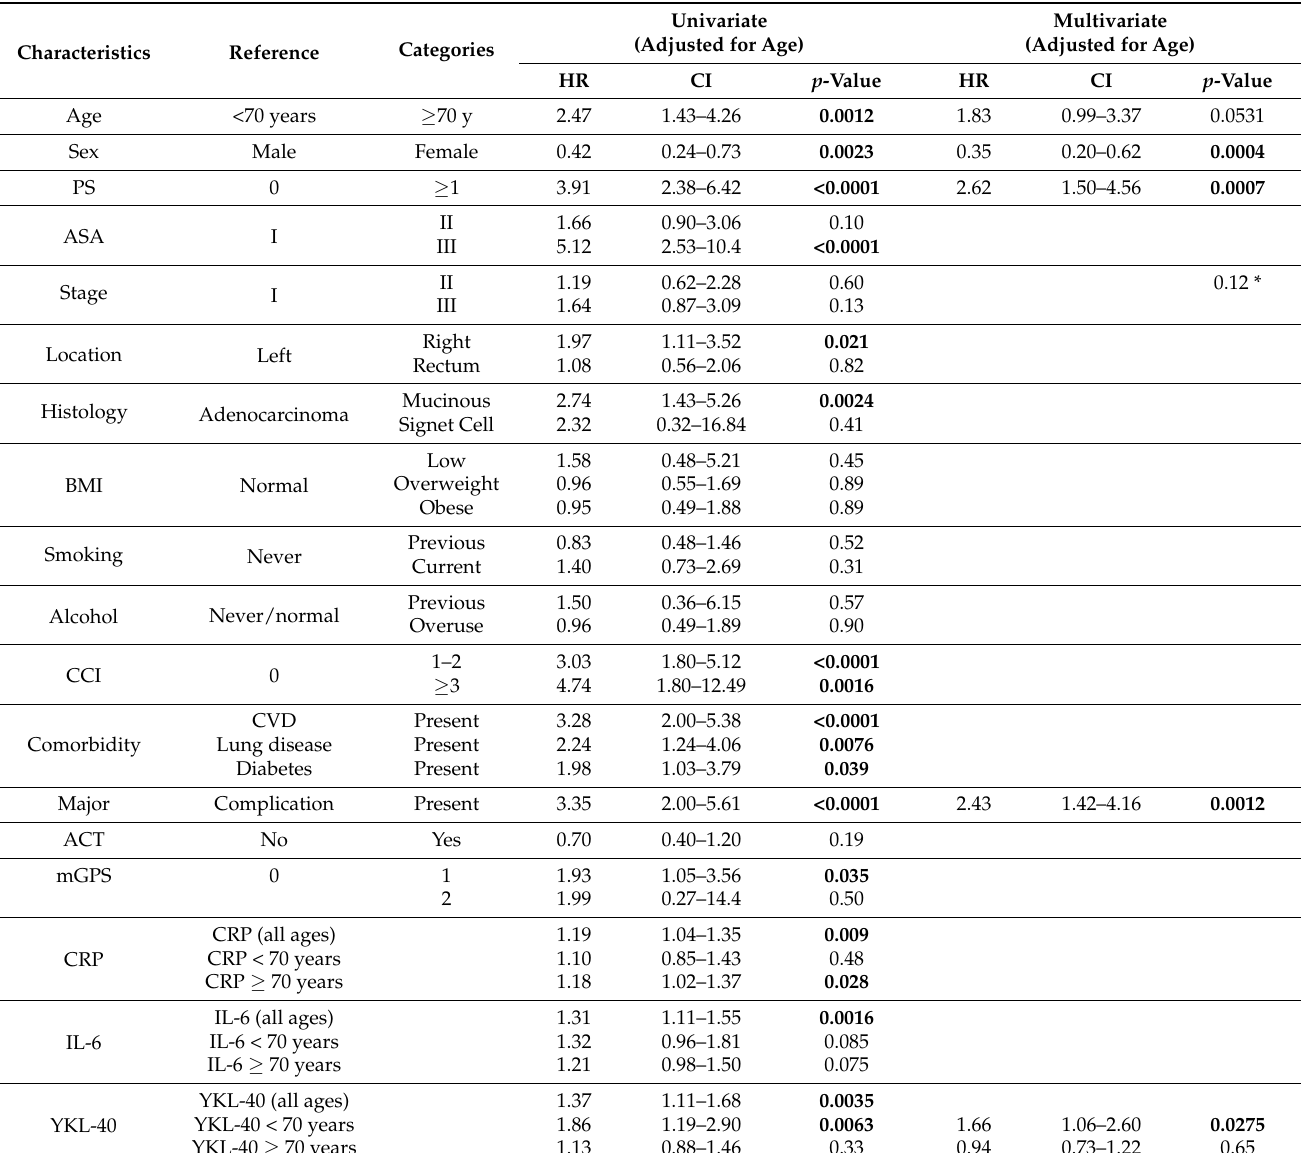
Table 5. Uni- and multivariate analyses of clinical characteristics, inflammatory biomarkers, and overall